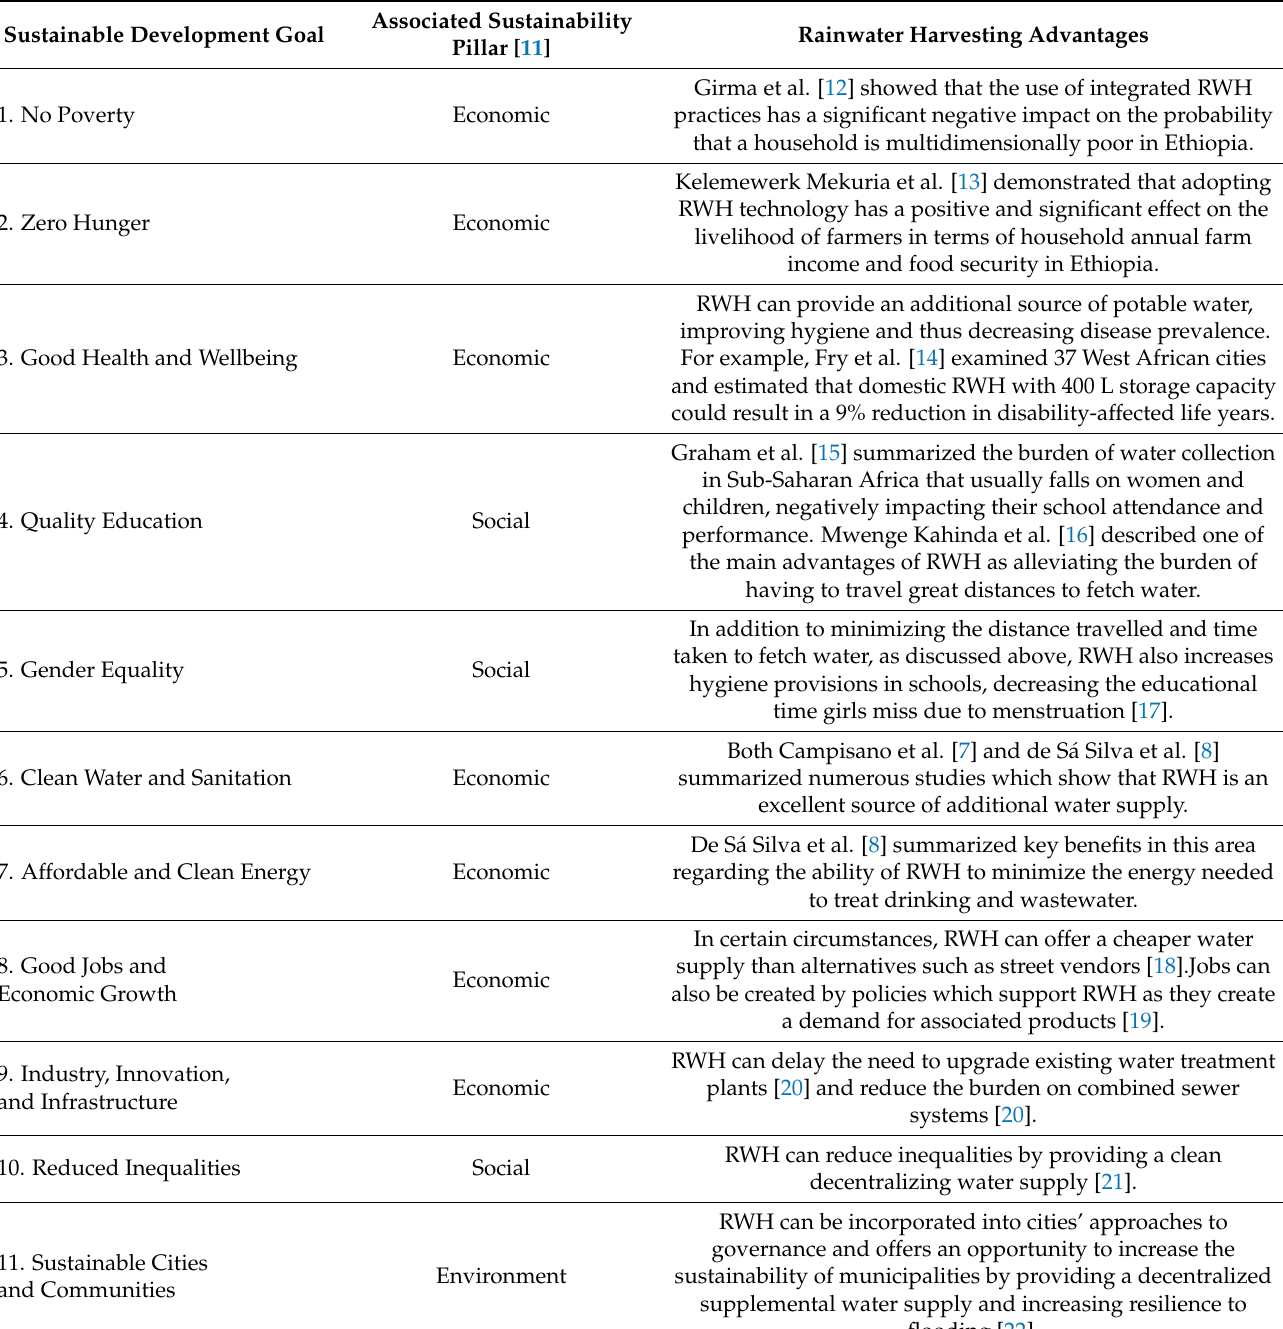
Table 1. Beneficial impacts of RWH on the achievement of the Sustainable Development